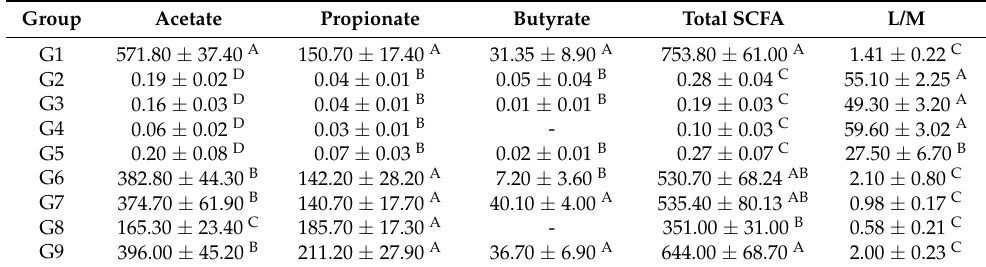
Table 3. Short-chain fatty acid (SCFA) concentration ( µ mol/g feces) in caecal samples and lactu- lose/mannitol ratio (L/M) obtained across the different groups after their respective intervention in phase 2 (treatment phase).